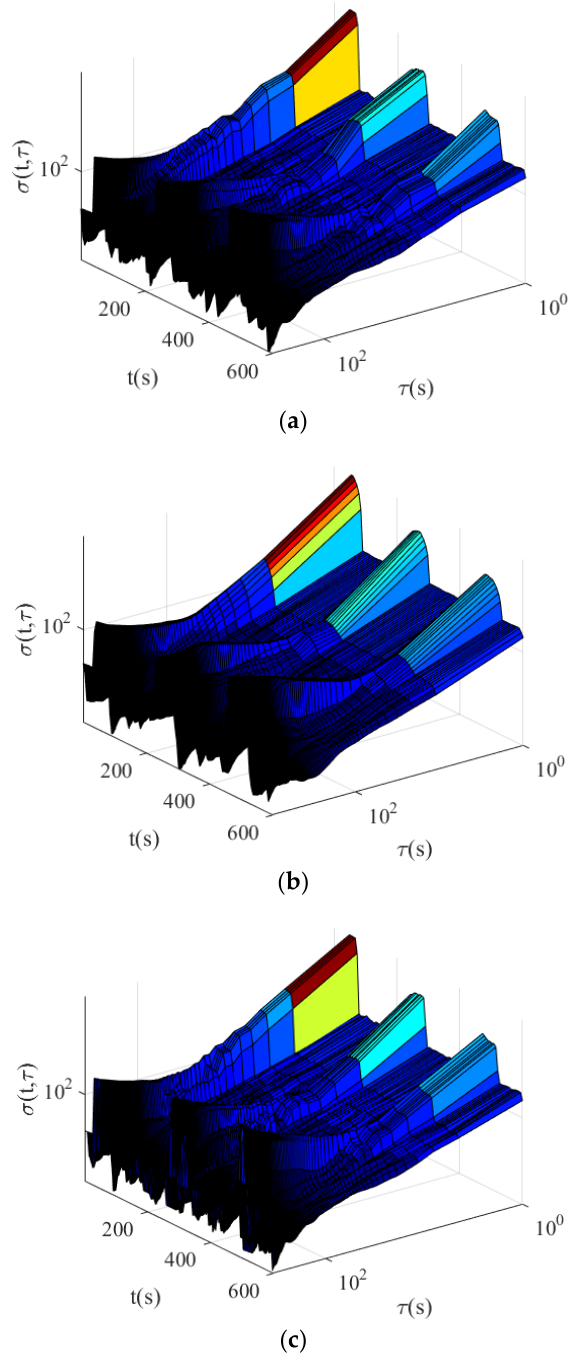
Figure 5. DAVAR results for different window lengths. ( a ) the window length of 1001; ( b ) the window length of 3001; ( c ) the window length of adaptive.